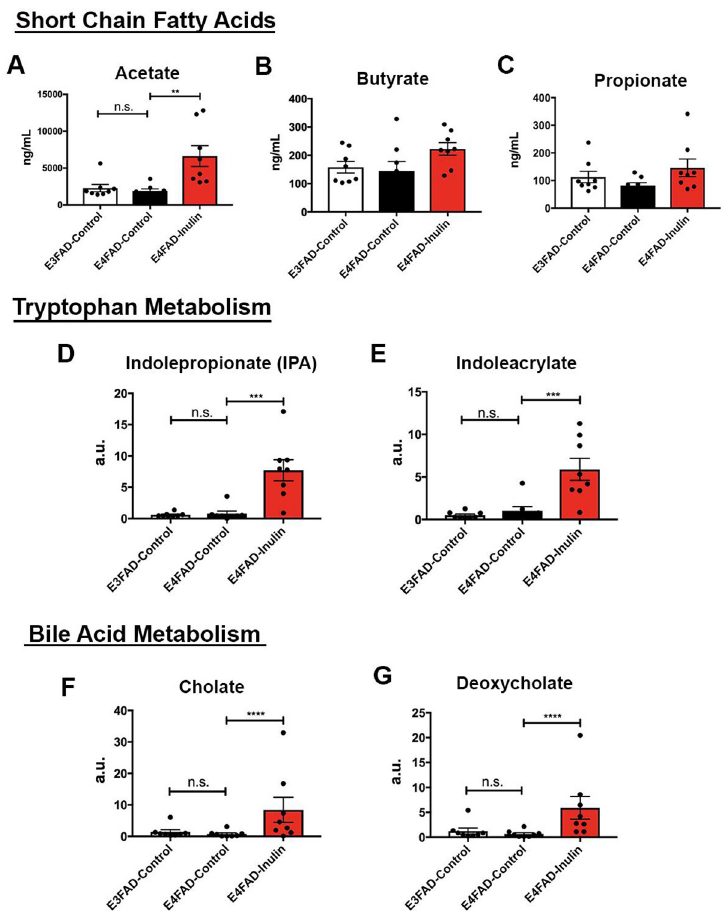
Fig 4. Analysis of inulin-induced changes in microbial metabolism changes in the periphery. E4 FAD-Inulin mice had a significant increase in (A) acetate and trend-level increases in (B) butyrate and (C) propionate. E4 FAD-Inulin mice had increased tryptophan metabolism, as indicated by the levels of (D) indolepropionate (IPA) and (E) indoleacrylate, and increased bile acid metabolism, as indicated by the levels of (F) cholate and (G) deoxycholate. n.s. = not significant; �� p < 0.01; ��� p < 0.001; ���� p <